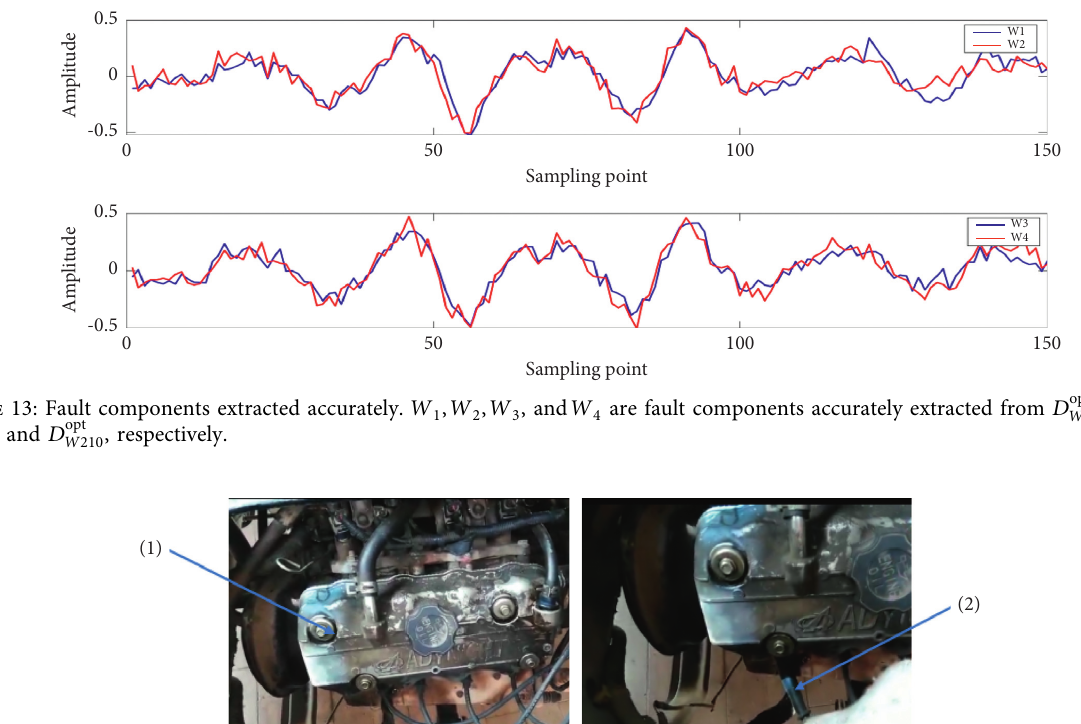
D opt W 210 , respectively.